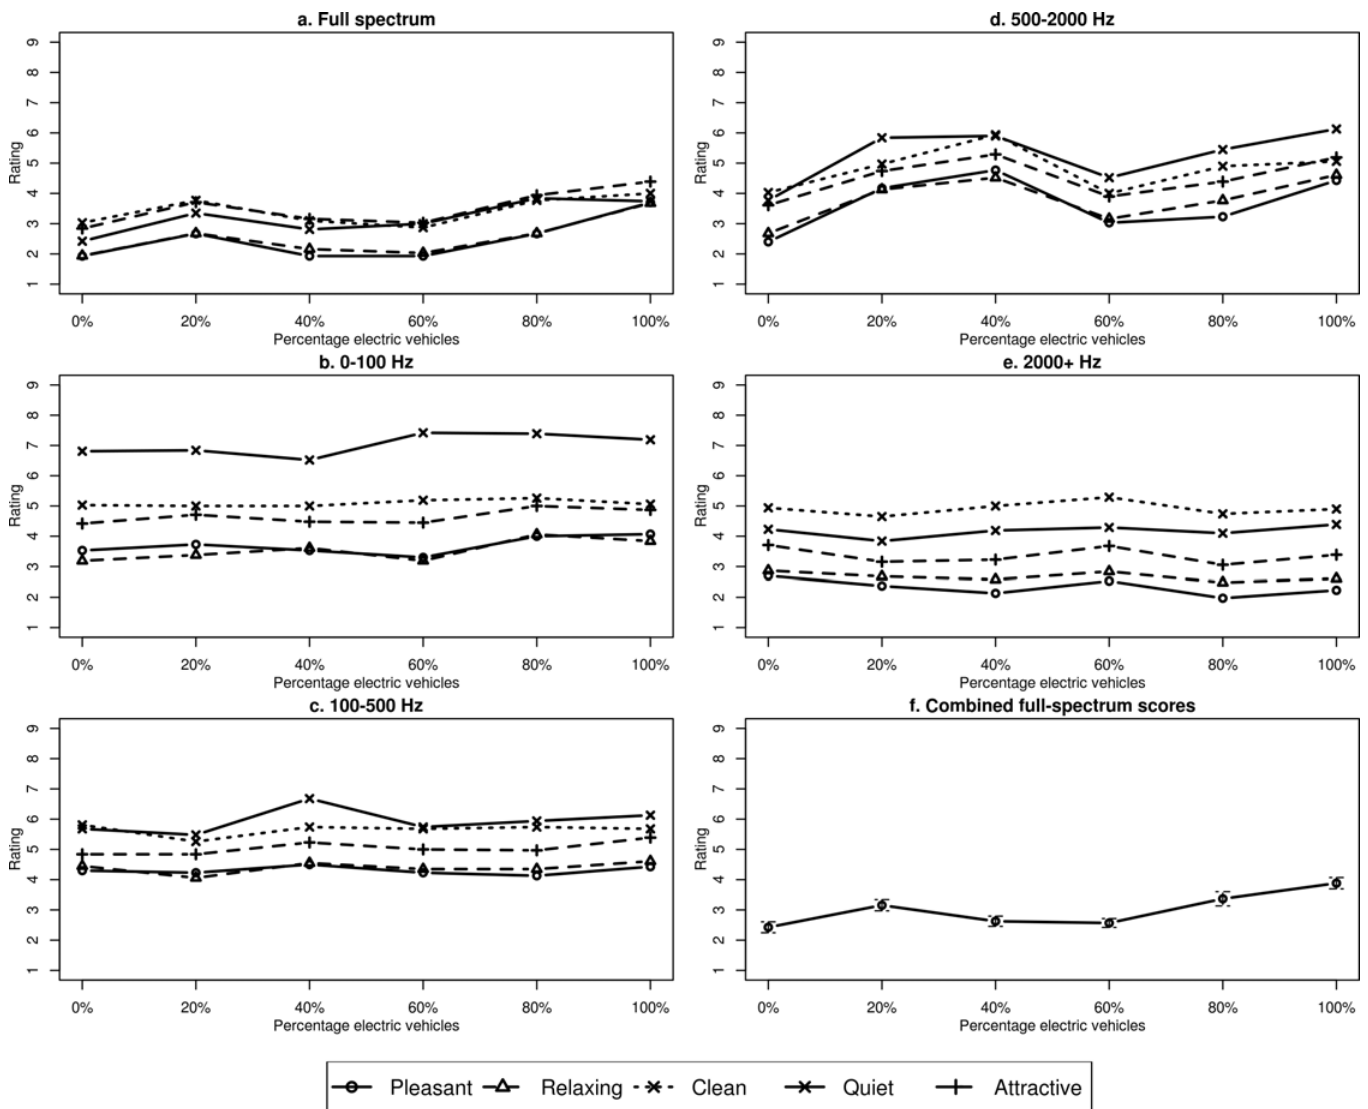
Fig 2. Subjective ratings for full-spectrum (a) and filtered (b-e) auralizations, plus combined preference ratings for the full-spectrum sounds (f), as a function of percentage of EVs in the auralization. Legend applies to a-e only; error bars in (f) represent standard errors of the mean